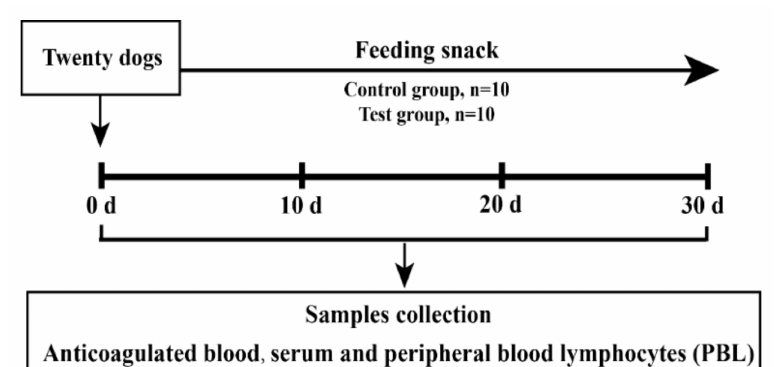
Figure 1. The schematic diagram of experimental